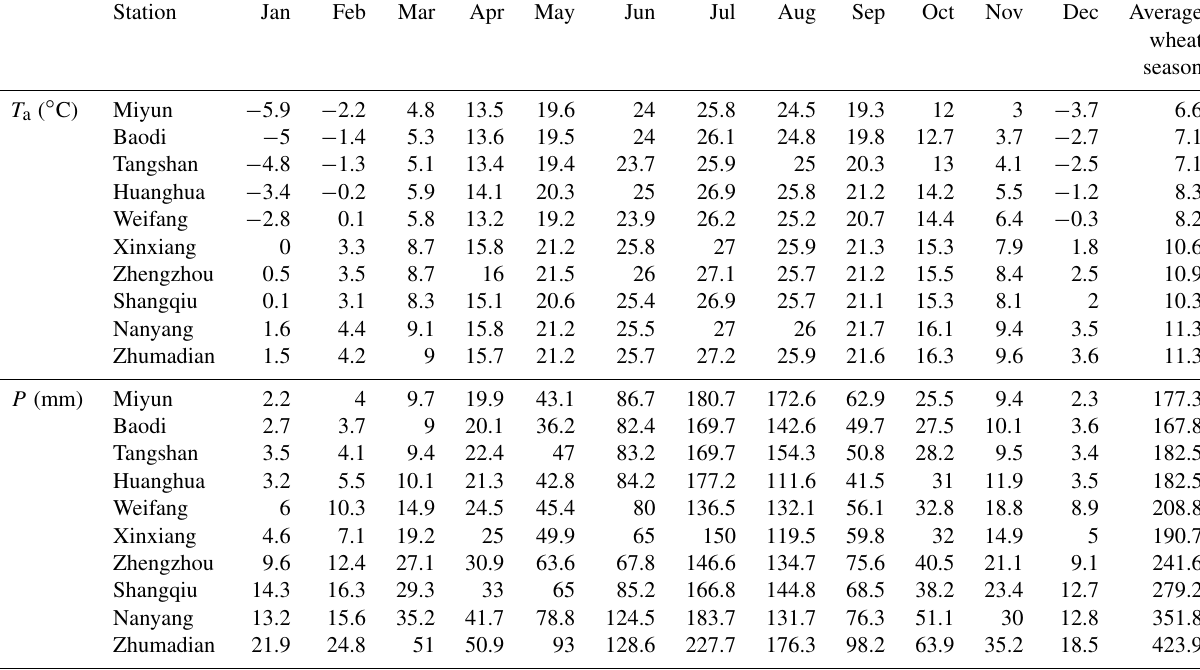
Table 1. Climate conditions of the selected stations in 1980–2012. Station